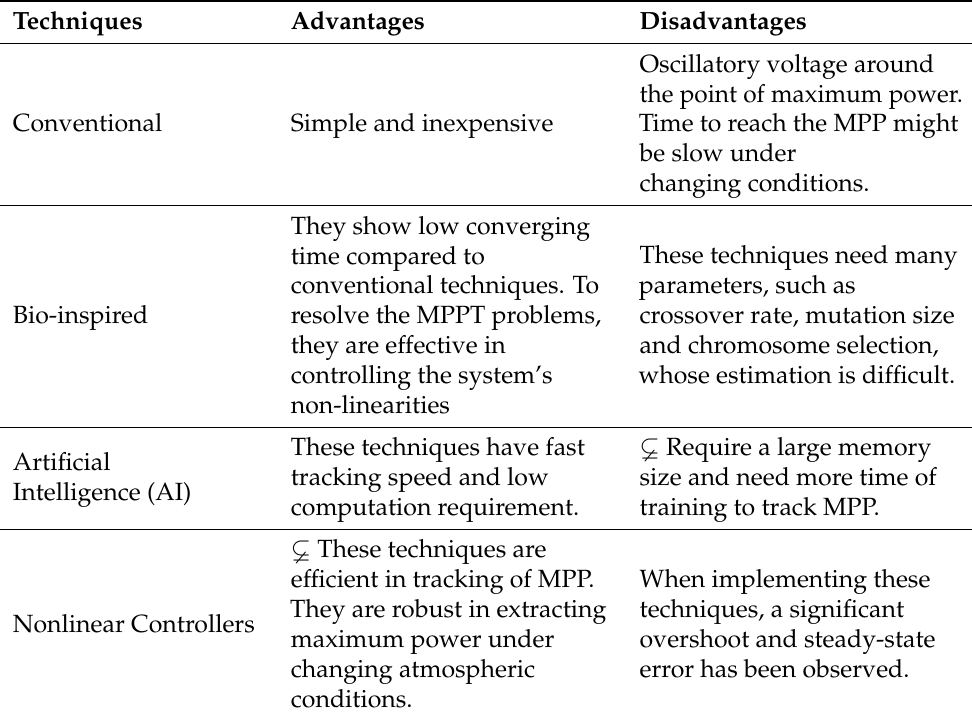
Table 1. Explanatory list of the existing control